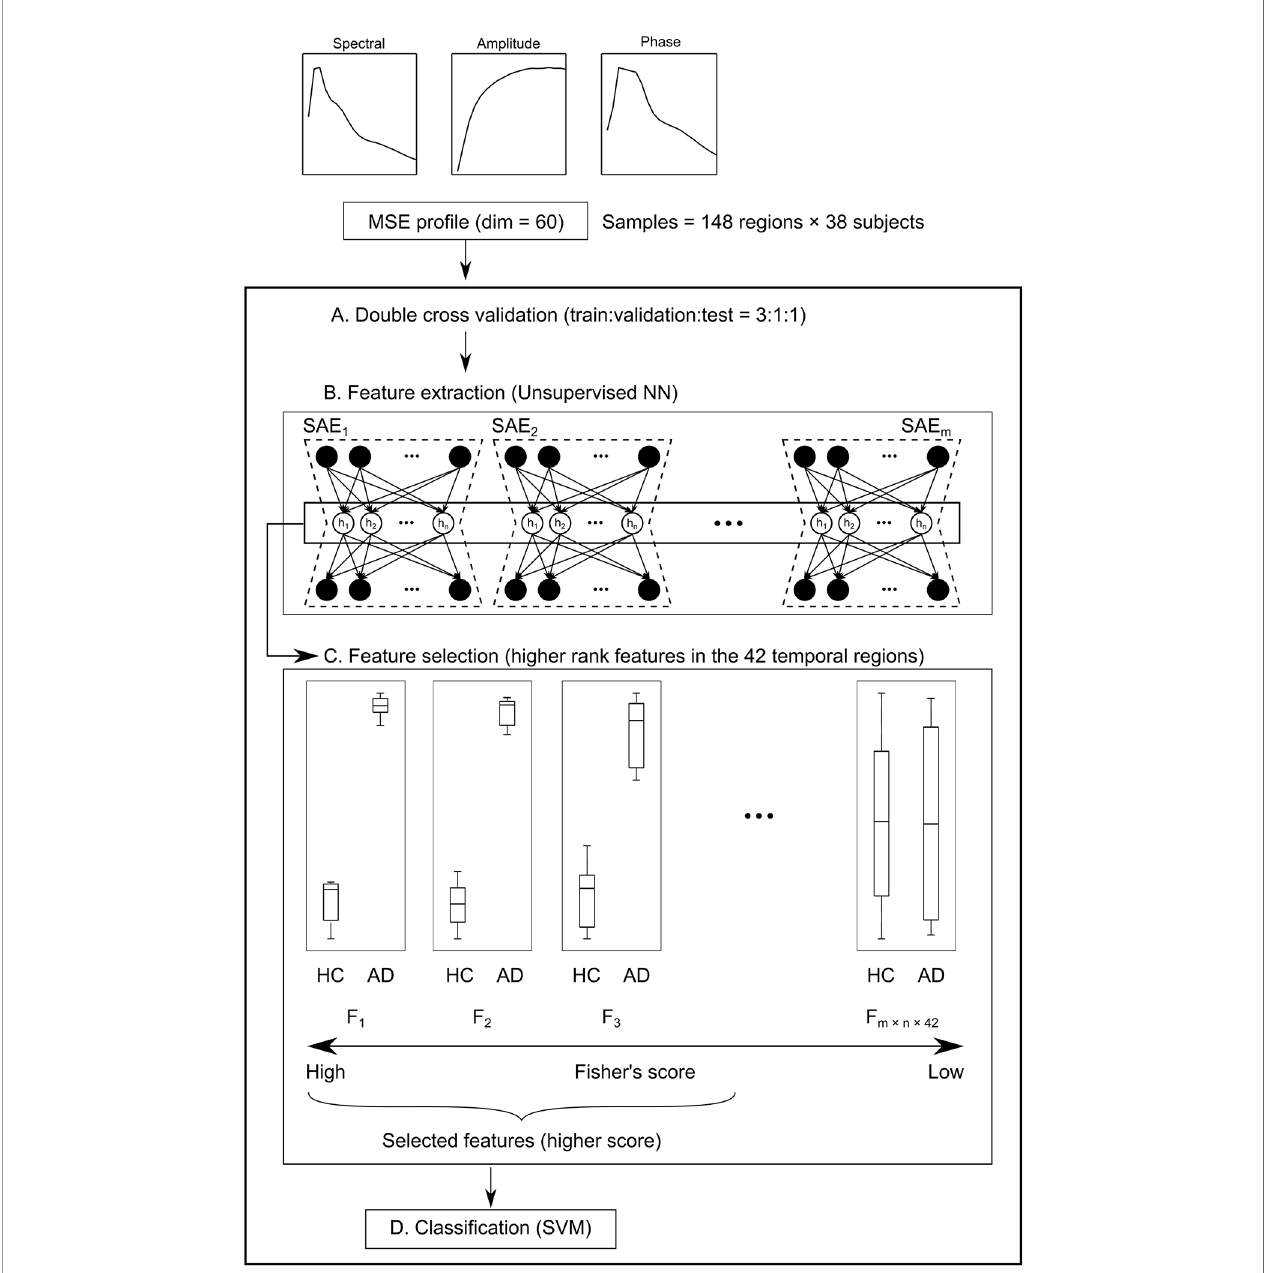
FIGURE 2 | Schema of the machine learning (ML) architecture. (A) First, subjects are divided into fi ve groups. Their data are assigned at a train:validation:test ratio of 3:1:1. (B) Next, the 60-dim multiscale entropy (MSE) pro fi les are processed by multiple sparse autoencoders (SAEs) to obtain a feature pool (F 1 – F m × n × 148 ) using regions × subjects as the number of samples (feature extraction). (C) Features of higher Fisher ’ s score of the temporal regions are selected (feature selection). (D) Finally, healthy controls (HC) and Alzheimer ’ s disease (AD) are classi fi ed by the support vector machine